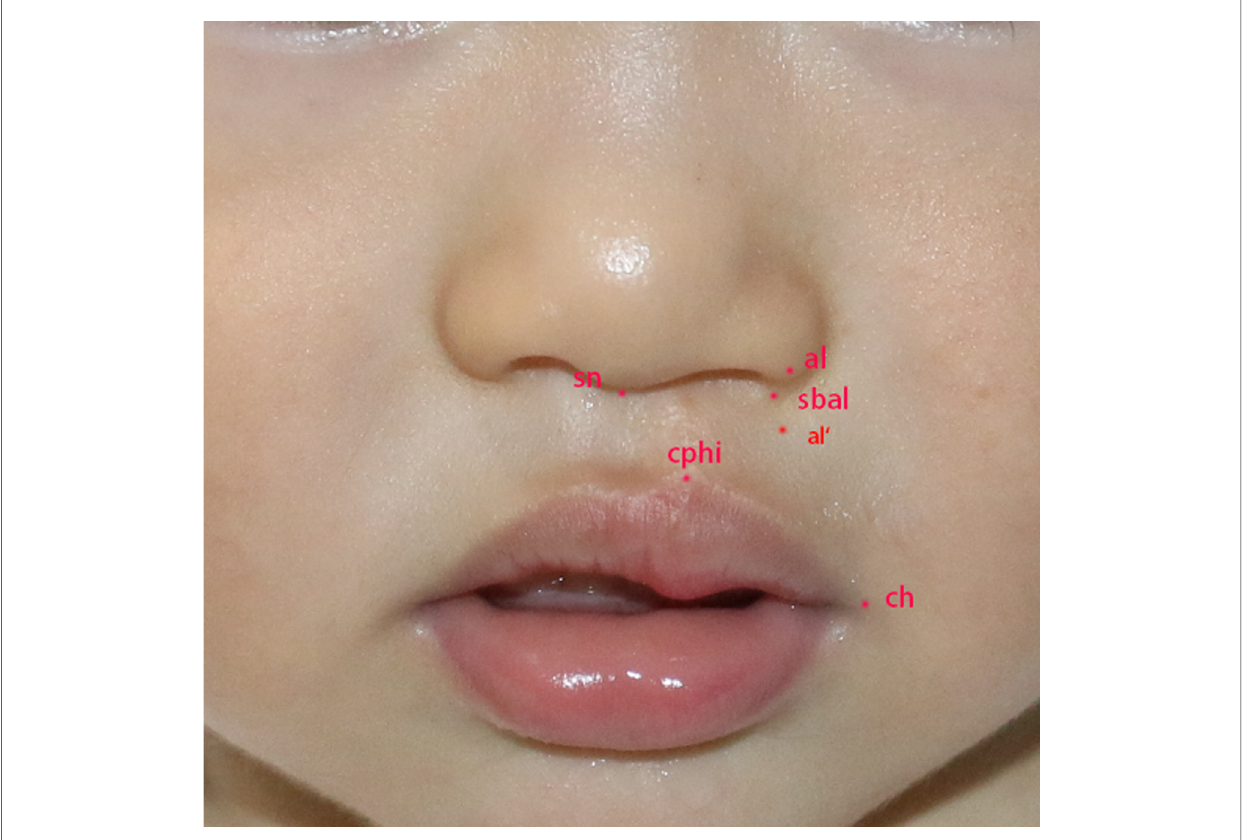
FIGURE 1 A patient with UCLP (right side) who underwent primary repair at 3 months of age showing the landmarks of anthropometric measurements. sn, the midpoint of the columellar base at which the lower border of the dorsal septum and the surface of the cutaneous upper lip meet; al, the most lateral point on each alar contour; al ’ , the dimension sn – al measured at sn – al ’ along the perpendicular to the horizontal line through sbal; sbal, the medial point at the inferior limit of each alar base that is tangential to the cutaneous upper lip; cphi, the point on each elevated margin of the philtrum immediately above the vermilion line; ch, the point located at each labial commissure; sn – al, heminasal width; sn – cphi and sbal – cphi, labial height; cphi – ch, labial width; sn – sbal, nasal sill width . UCLP, unilateral cleft lip and